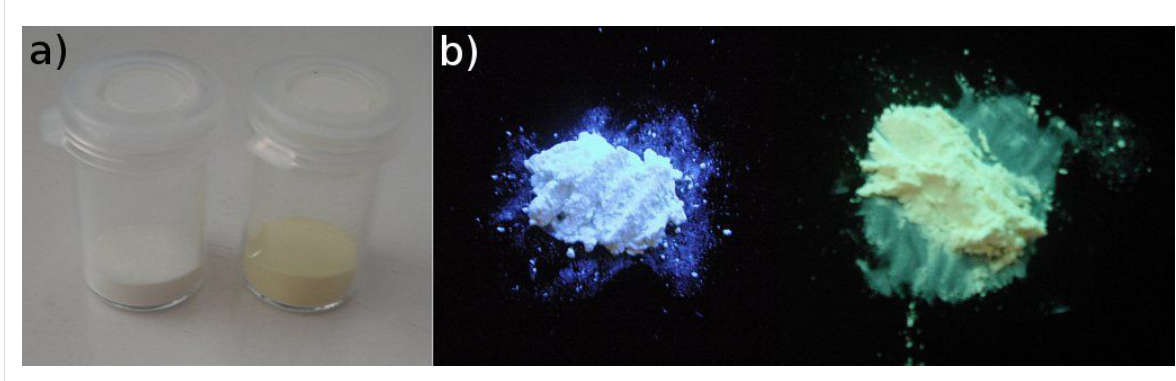
Figure 8: Visual appearance of MCM-ACR and MCM-ACR + Sc(OTf) 3 under normal (a) and UV light (b).